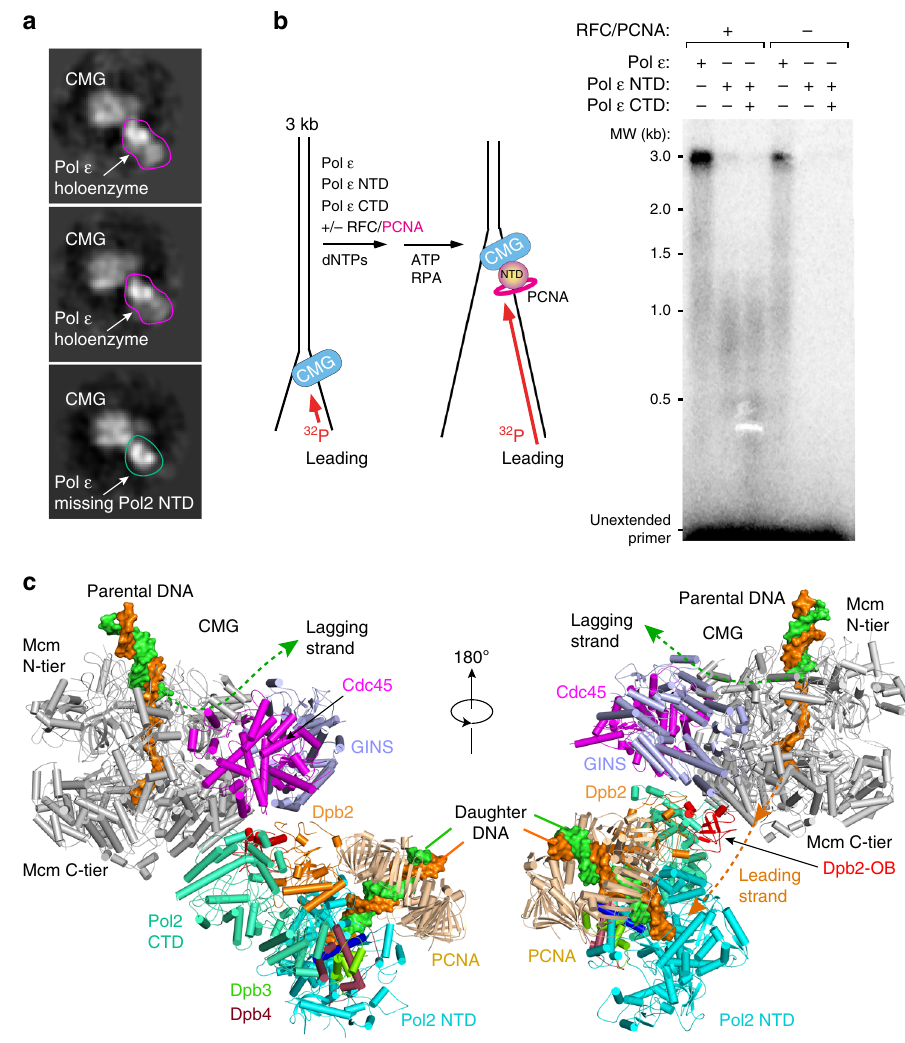
Fig. 4 Atomic model of the leading strand replisome. a 2D class averages of cryo-EM images of puri fi ed native Pol ε in complex with recombinant CMG. b A 3-kb forked DNA, primed with a 5 ′ - 32 P-DNA oligonucleotide, is replicated in the presence of CMG, RPA, PCNA, and RFC, using either Pol ε holoenzyme (lane 1), catalytic Pol2 NTD (lane 2), or catalytic Pol2 NTD plus Pol2 CTD (lane 3). Lanes 4 – 6 are the same as lanes 1 – 3, except in the absence of PCNA and RFC. c A model showing how the CMG helicase is coupled with the holoenzyme Pol ε in which the Dpb2 OB domain likely bridges the leading strand DNA path from CMG to the Pol ε catalytic entry. The leading strand path is drawn as an orange dashed line with two arrowheads indicating the ssDNA